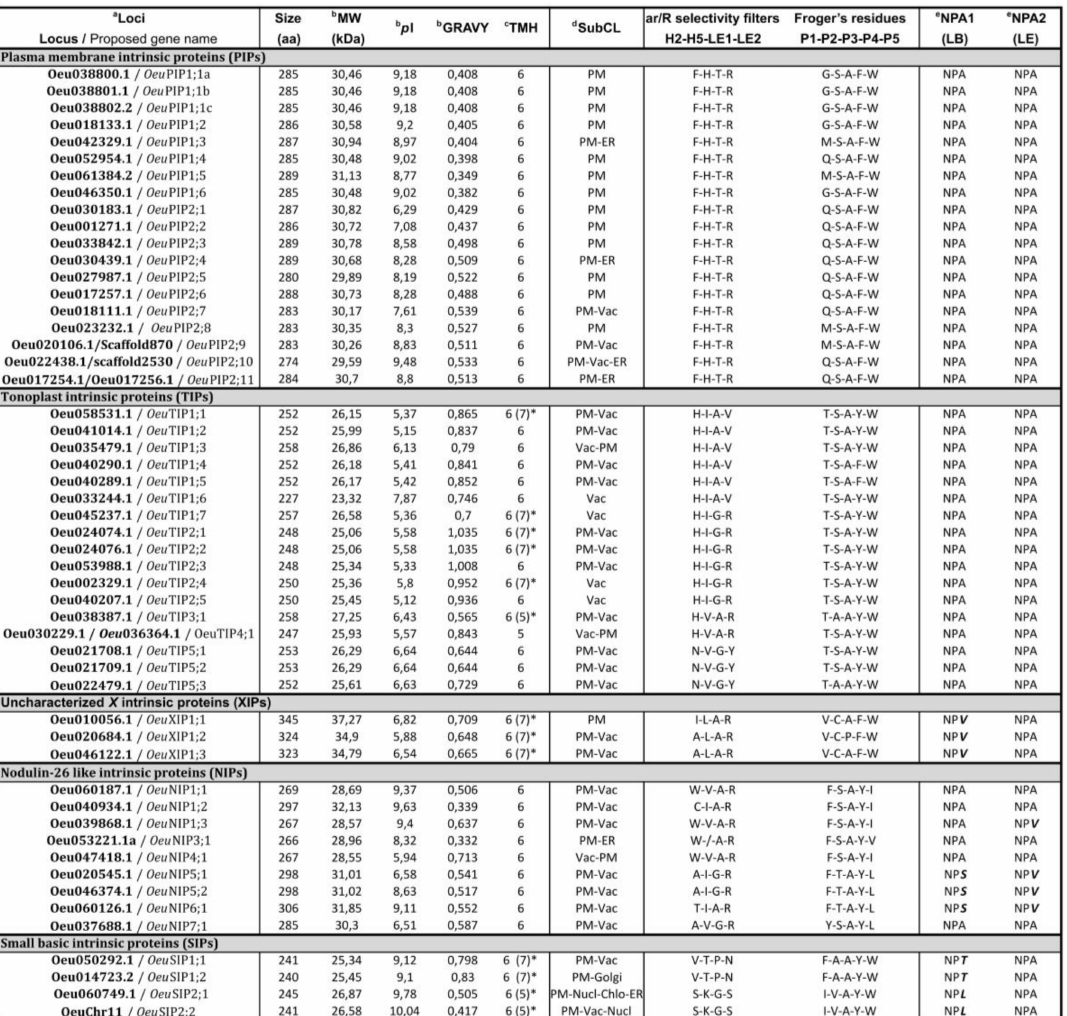
Figure3. Nomenclatureandproteinpropertiesofthewildspecies Oleaeuropaea var. sylvestris